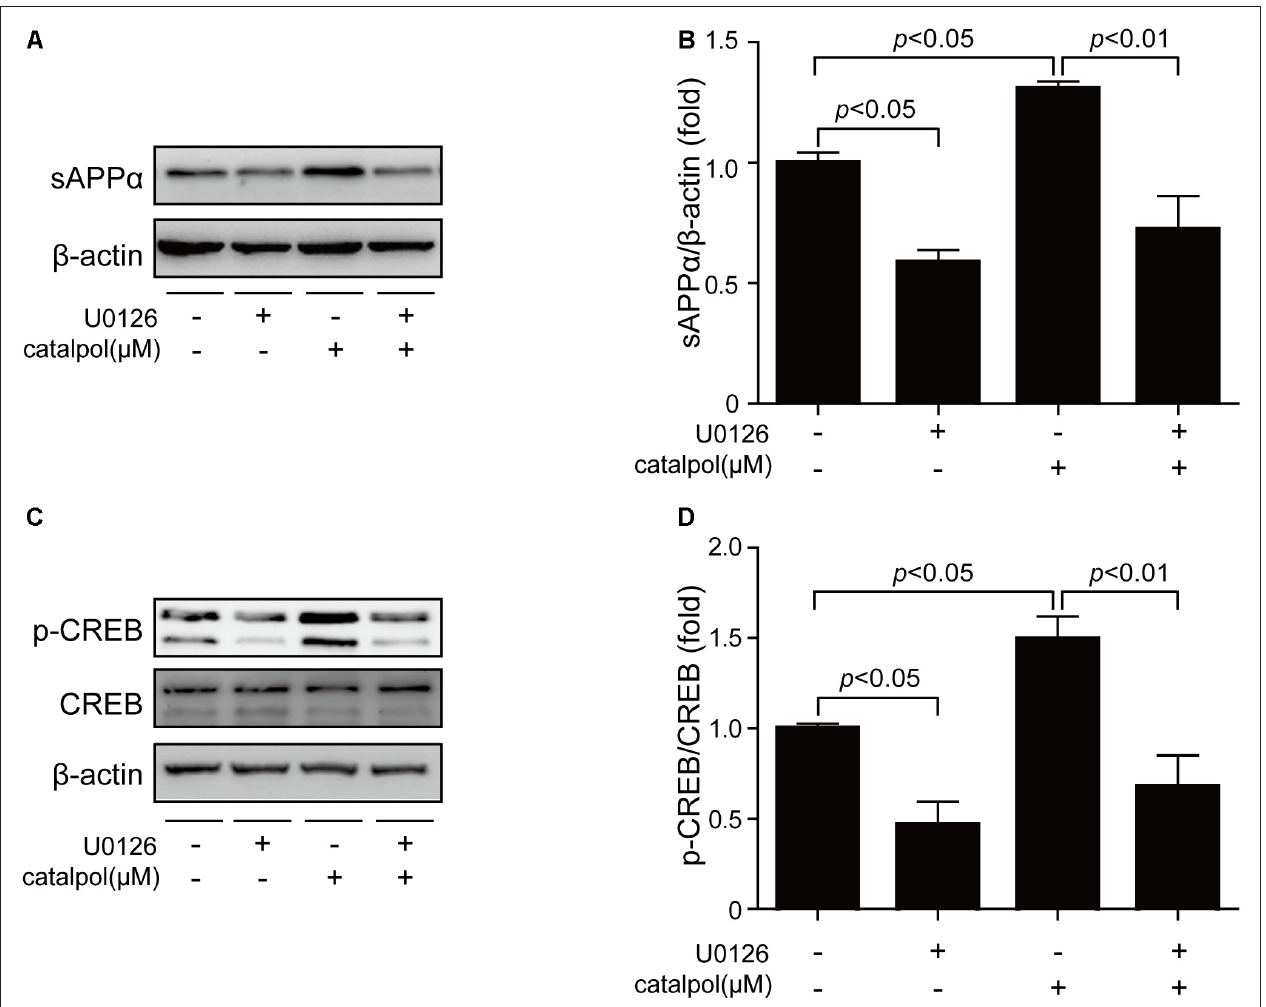
FIGURE 7 | Catalpol promoted sAPP α expression through ERK/CREB signaling pathway. SweAPP N2a cells were pre-treated with the ERK inhibitor U0126 for 2 h, and then treated with 200 µ M catalpol for 18 h. (A) Immunoblot images and (B) quantifications show that the expression levels of sAPP α were assessed by western blot. (C,D) The expression levels of p-CREB were markedly decreased in cells treated with both U0126 and catalpol, compared with catalpol-treated cells ( C , representative pictures; D , quantification), compare to these from catalpol-treated cells. The data are expressed as the mean ± SEM. n = 3. The p values were calculated using one-way